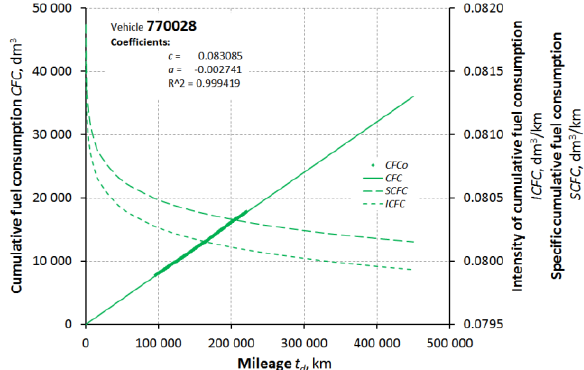
Fig . 3. Energy footprint of the vehicle